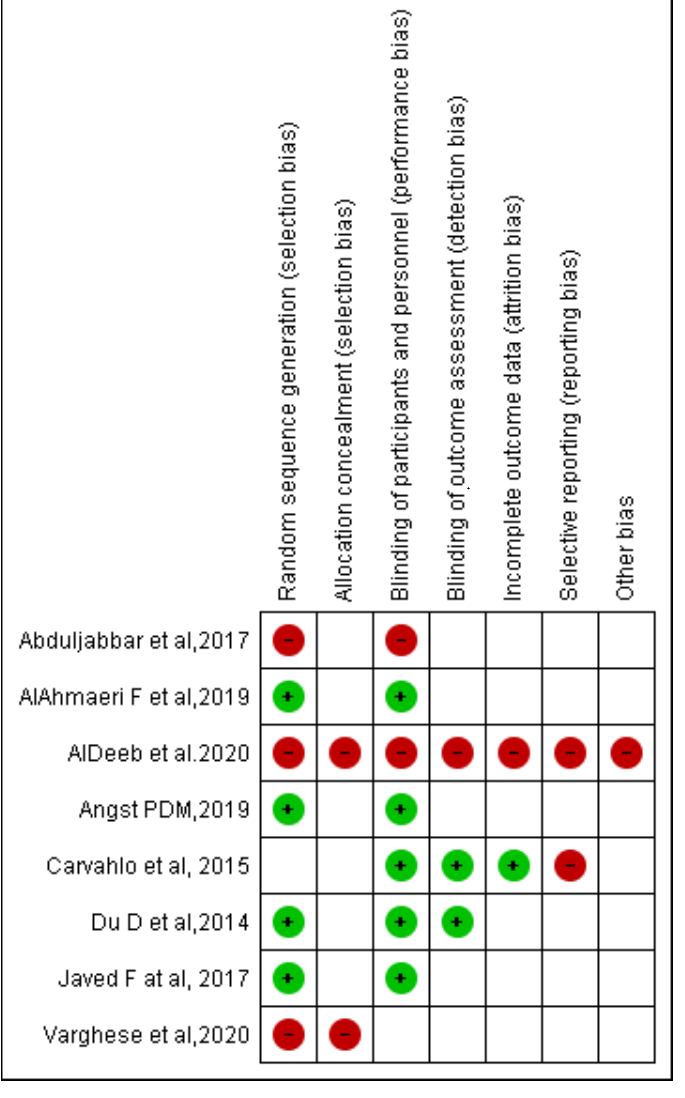
Figure 4. Risk of bias summary: review authors judgment about each risk of bias item for each included RCT.